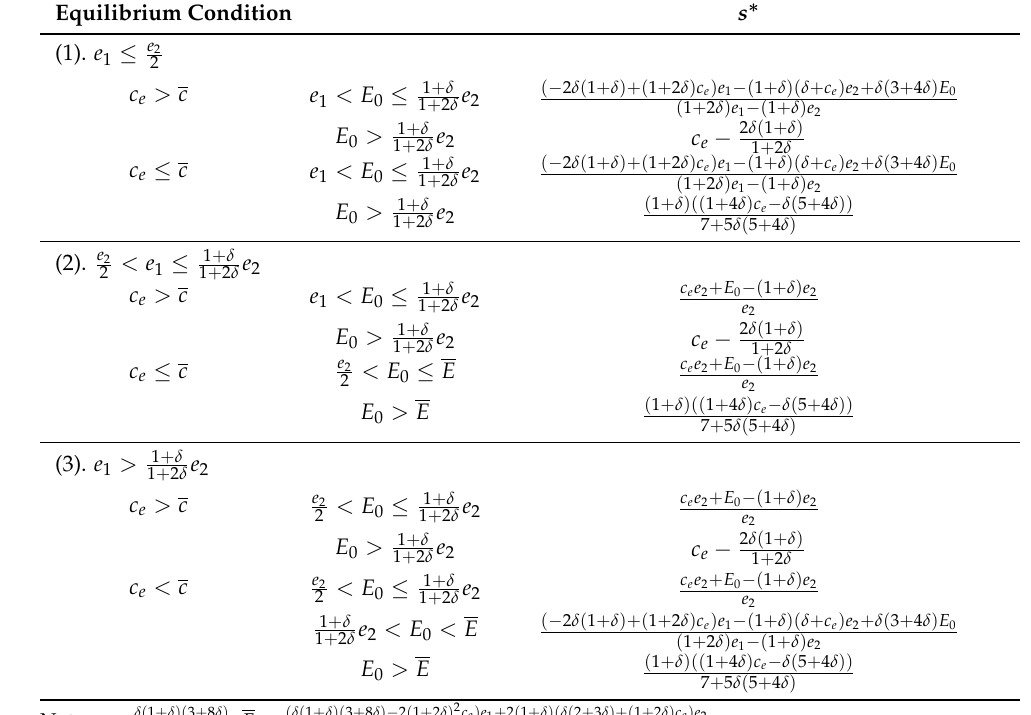
Table 10. The optimal decision on s . Equilibrium Condition s